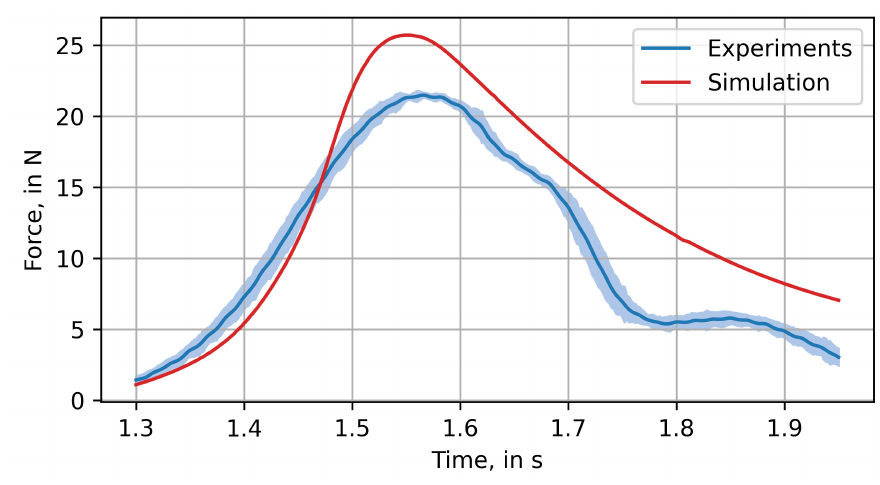
Figure 6. Comparison between the vertical loads of the experiment and the numerical simulation.